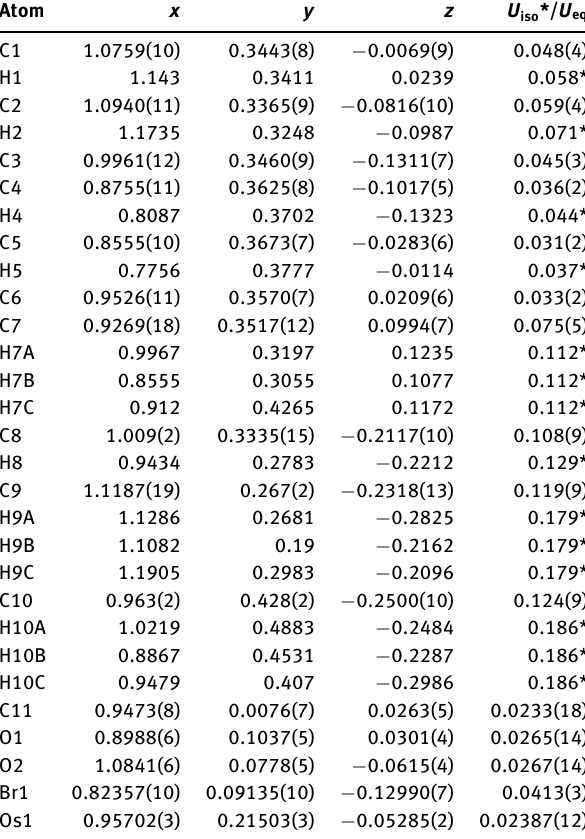
Table 2: Fractional atomic coordinates and isotropic or equivalent isotropic displacement parameters (Å 2